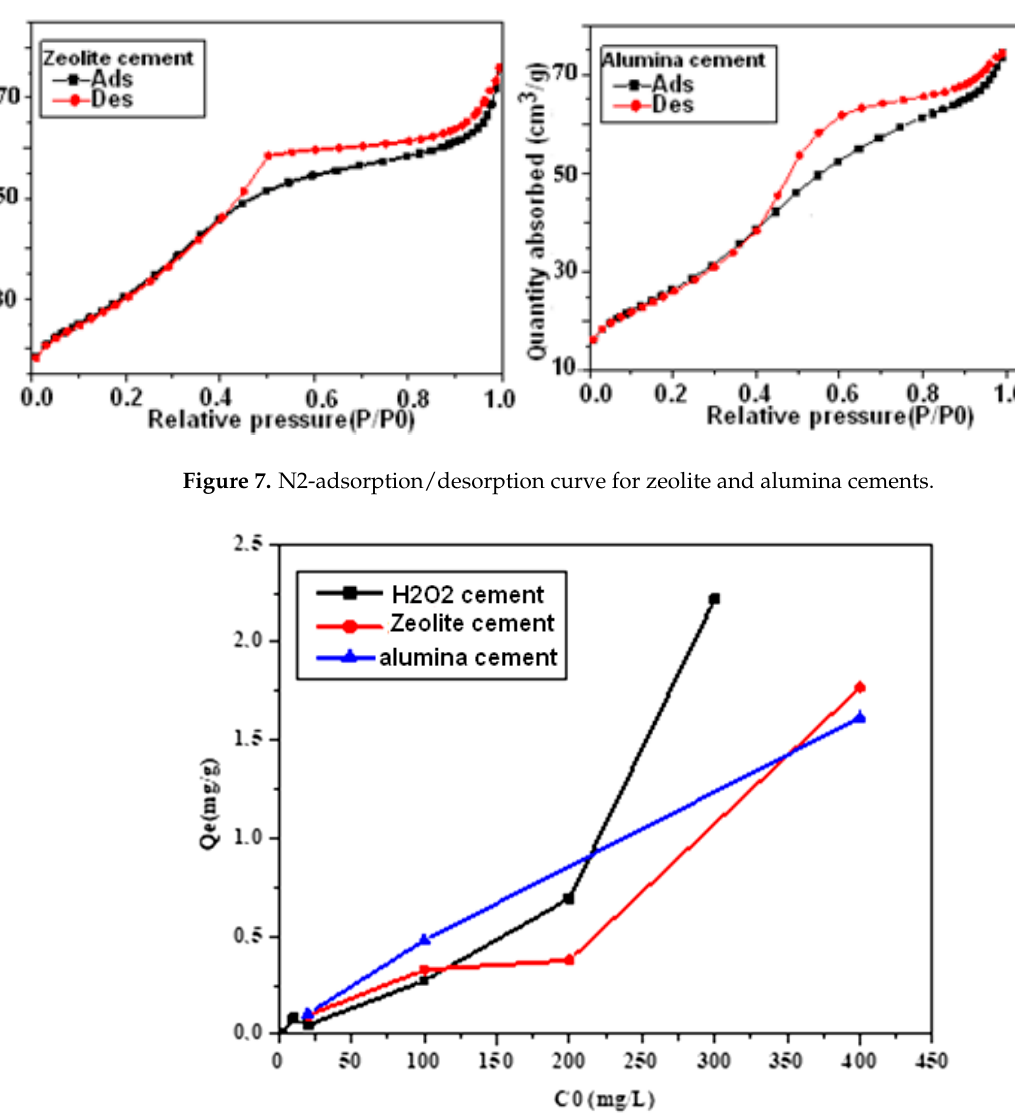
Figure 8. Influence of the initial concentration of fluoride on adsorption.